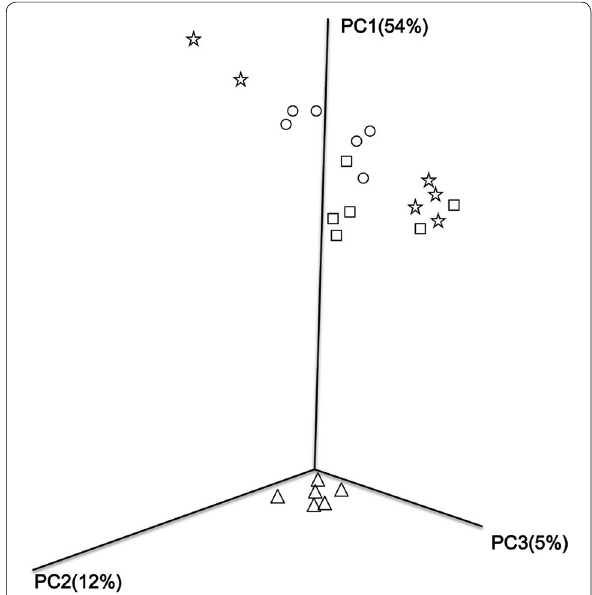
Fig. 4 Principal components analysis of pyrosequencing reads obtained from soils treated with different fertilization strategies based on the weighted Fast UniFrac metric. The first three axes are drawn and the percent of variance explained by each axis is given. Treat- ment: (circle) CK, no fertilizer; (square) PK, inorganic phosphorus and potassium fertilizer; (triangle) NPK, inorganic P, K and N fertilizer; (star) MPK, inorganic P and K fertilizer plus manure